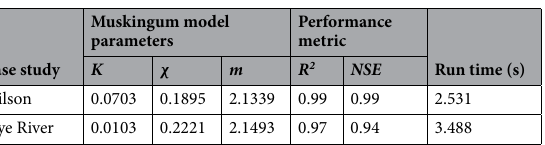
Table 5. Muskingum model parameters with performance metrics and run